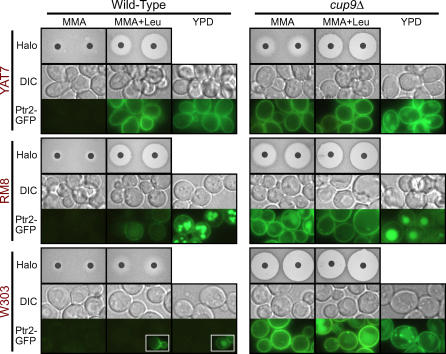
Inter-Strain Variation in PTR2 Expression and Sensitivity to the Toxic Dipeptide Ala-EthMedia composition and the absence of Cup9p affect expression of GFP-tagged PTR2 and Ala-Eth toxicity. Three types of media were tested: MMA, MMA+Leu, and YPD. “MMA” refers to minimal nitrogen medium containing 1 mg/ml allantoin as the nitrogen source. “+Leu” refers to the addition of 30 μg/ml leucine, an inducer of PTR2 expression. YPD is a standard rich S. cerevisiae medium; the presence of methionine precludes its use for the halo assay. The left and right discs in each halo assay panel contained 0.1 μmoles and 0.2 μmoles of Ala-Eth, respectively. Microscopy was conducted using cells grown to log phase in the indicated media. Three strains were imaged: W303, RM8, and YAT7. In each strain, the endogenous PTR2 gene contained a C-terminal tag consisting of a FLAG epitope, two copies of GFP, and a 6xHis tag. The insets depict representative cells from the small subpopulation of W303 cells that exhibited fluorescence.